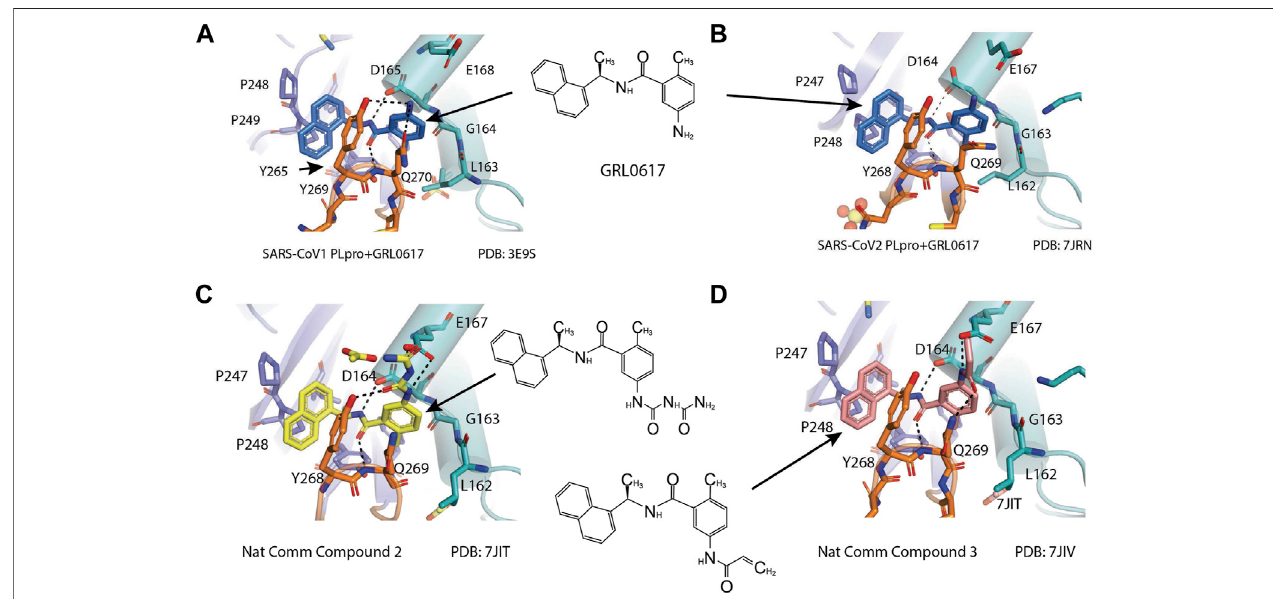
FIGURE 4 | Close-up view of interaction between SARS-CoV-1 PLpro and inhibitors in crystal structures. PLpro is shown as cartoon with sticks representation shown for residues involving contact with inhibitors. Inhibitors are shown as sticks. Hydrogen bonds are labeled with dashed lines. (A) SARS-CoV-1 PLpro with GRL0617 (PDB: 3E9S). (B) SARS-CoV-2 PLpro with GRL0617 (PDB: 7JRN). (C) SARS-CoV-2 PLpro with compound 2 (PDB: 7JIT). (D) SARS-CoV-2 PLpro with compound 3 (PDB: